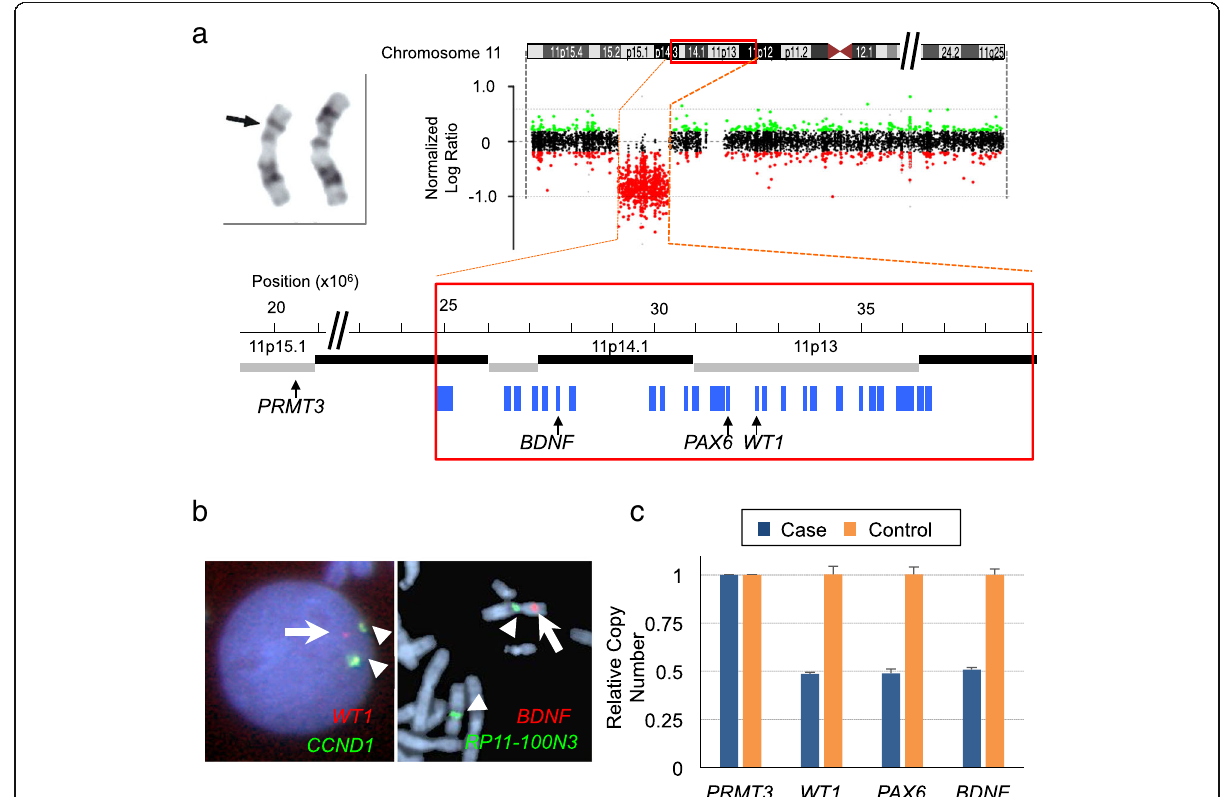
Fig. 1 Genetic analyses of the present cases. a Array-CGH data for the present case. The left-top panel depicts the abnormal G-band pattern (arrow) of chromosome 11 in the peripheral leukocytes. On the right top, the log 2 values of relative copy numbers are plotted against the base position (x10E6) at chromosome 11. Color codes represent gain (green) or loss (red) of the probed regions. The horizontal dashed lines indicate the thresholds of duplication (0.5) and heterozygous deletion ( − 1.0). The lower-panel shows a magnified view of the deleted region. G- band locus (thick, black and gray lines) and protein-coding genes (blue boxes) are mapped on the coordinates available at the UCSC genome browser (GRCh37/hg19). Chromosomal locations of the three WAGR syndrome-associated genes ( BDNF , PAX6 and WT1 ) are denoted under the diagram. b The FISH image. The green (arrowheads) and red (arrows) signals show CCND1 (control) and WT1 loci, respectively. Note that one copy of the WT1 (arrow) is missing while the two copies of CCND1 signals (arrowheads) are unaffected. c Quantitative PCR data for this case and a healthy control.